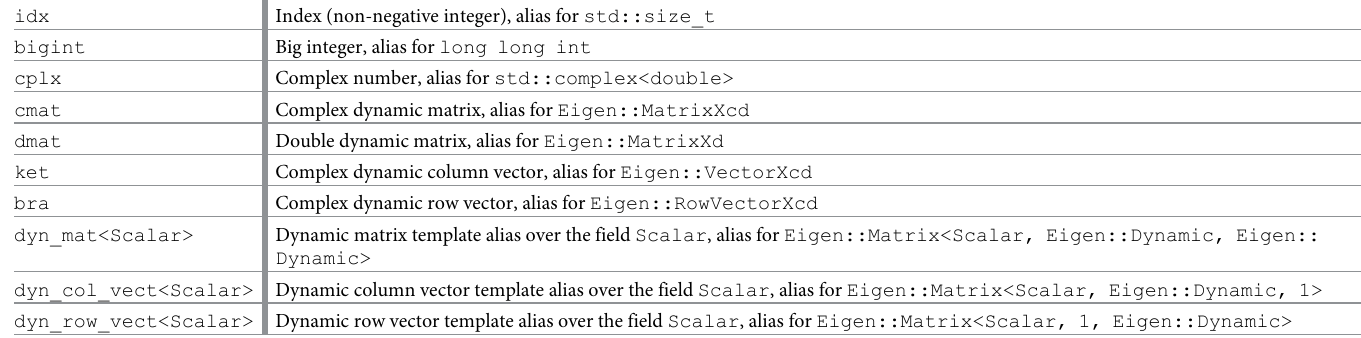
Table 1. User-defined data types.